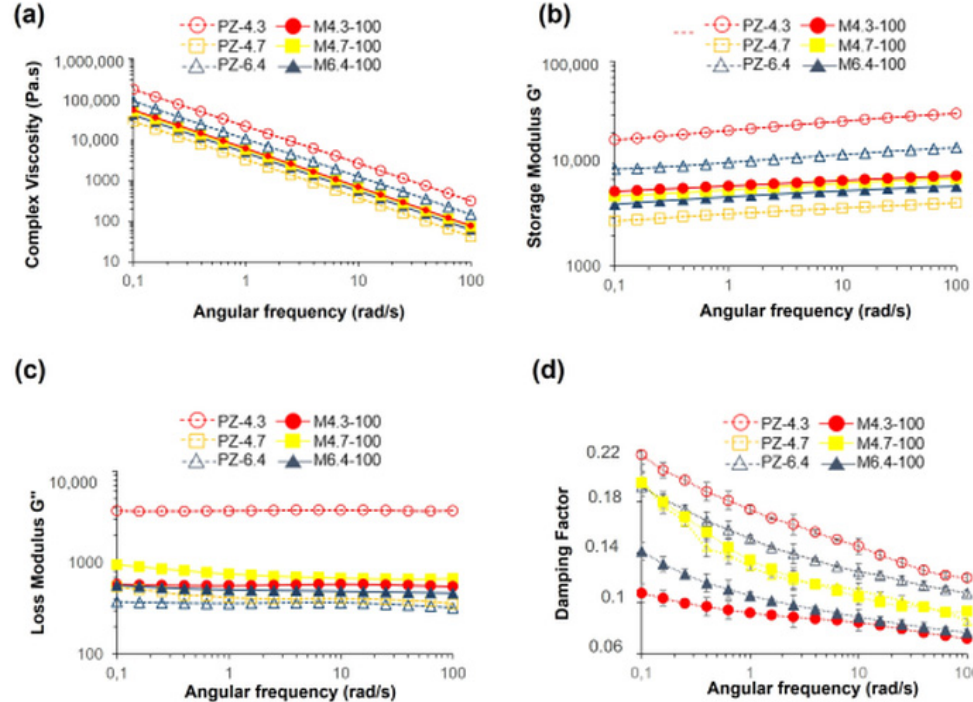
Figure 3. Rheological analysis of the hydrogels; ( a ) complex viscosity, ( b ) storage modulus G’, ( c ) loss modulus G’’, and ( d ) damping factor.